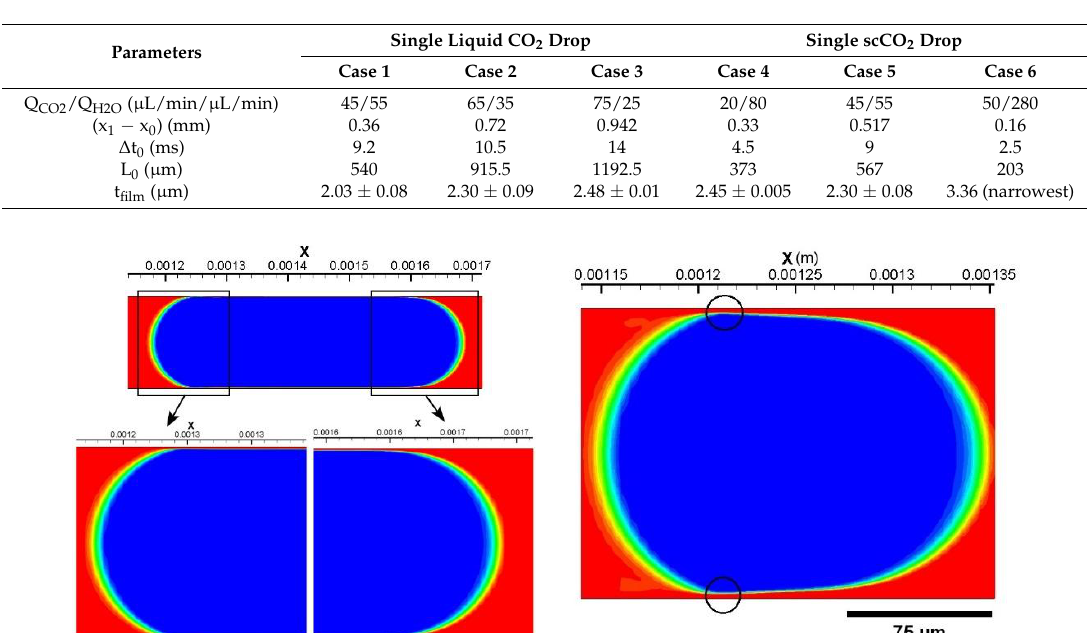
Table 3. Time duration of the drop preparation stage ( ∆ t 0 ), drop length (L 0 ) at the end of preparation stage, and the film thickness (t film ) of case 1 to 6. (x 1 − x 0 ), as an initialized drop length, is compared to the computed drop length L 0 .